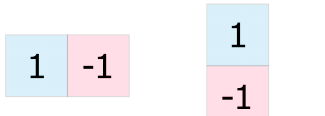
Figure 3. The 2 × 1 kernels that are used to form jet